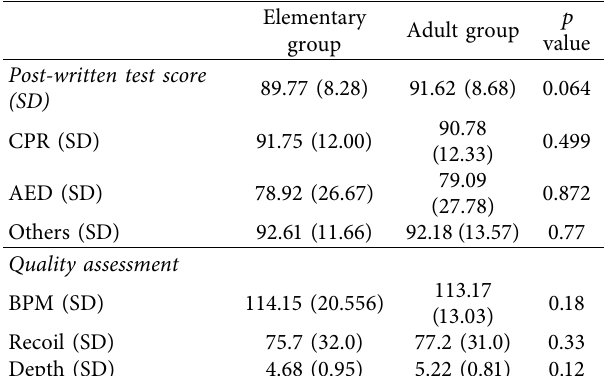
Table 2: Assessment of the cardiopulmonary resuscitation training